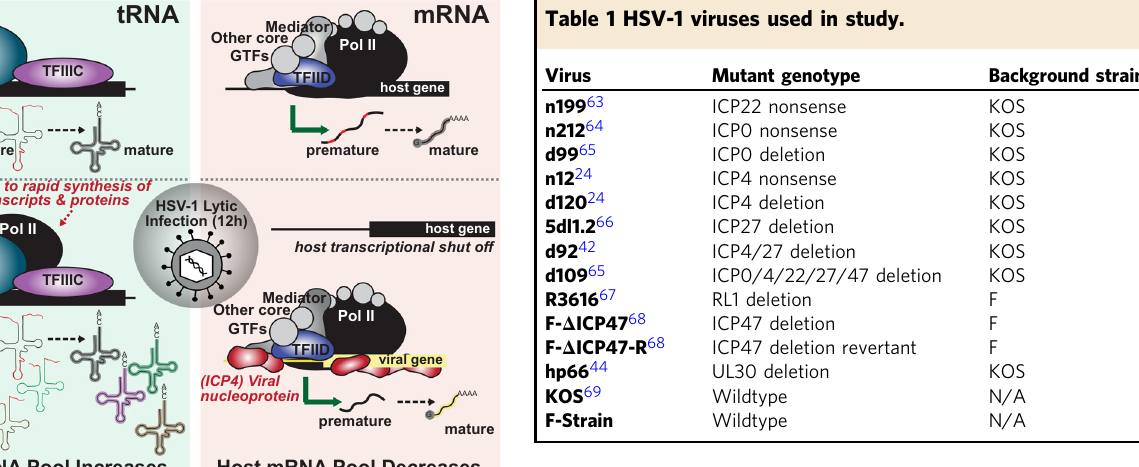
Table 1 contains a detailed list of all viruses used in this study. n199, R3616, F- Δ ICP47, and KOS were prepared and titered in Vero cells. Other virus stocks were prepared and titered in the following Vero-based complementing cell lines: E5 (ICP4 + , n12, d120-complementing 41 ); E11 (ICP4/ICP27 + , 5dl1.2, d92-